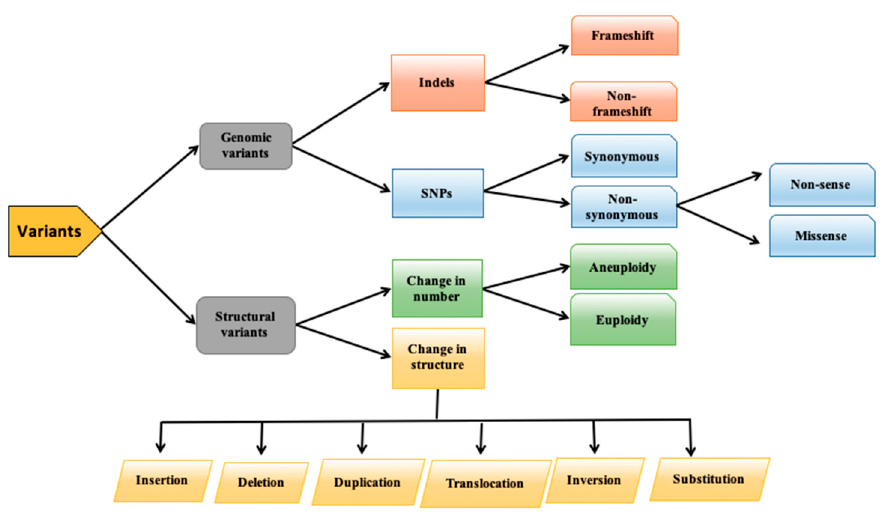
Figure 1. Classification of variants.